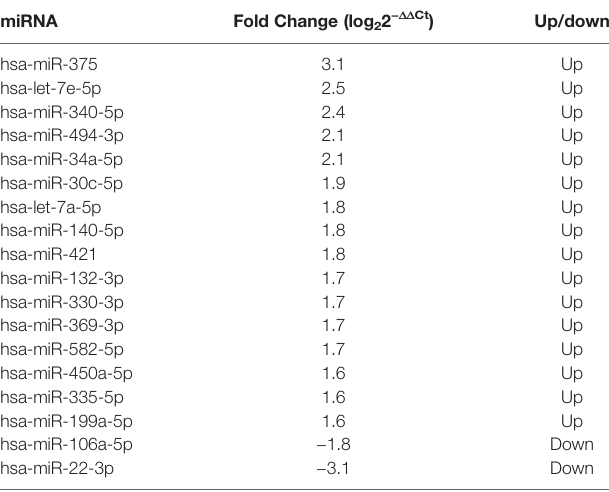
TABLE 2 | Differentially expressed miRNAs after 3 months of GH treatment with respect to the baseline in 10 prepubertal patients with IIGHD.